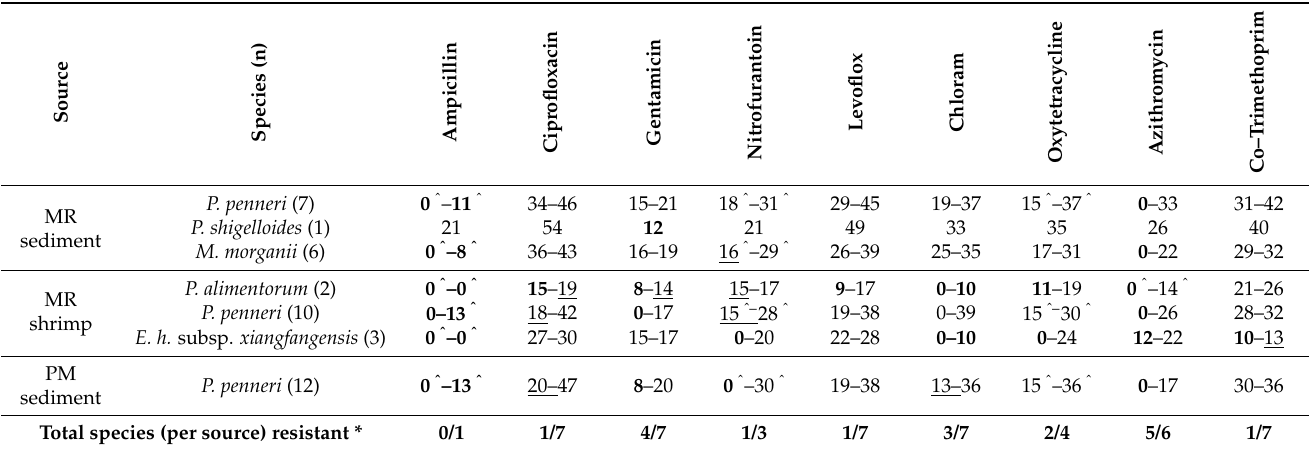
Table 4. The zone diameter (mm) of the bacteria isolated from sediment or shrimp. Bold values represent resistant levels and underlined values represent intermediate levels. ˆ denotes intrinsic